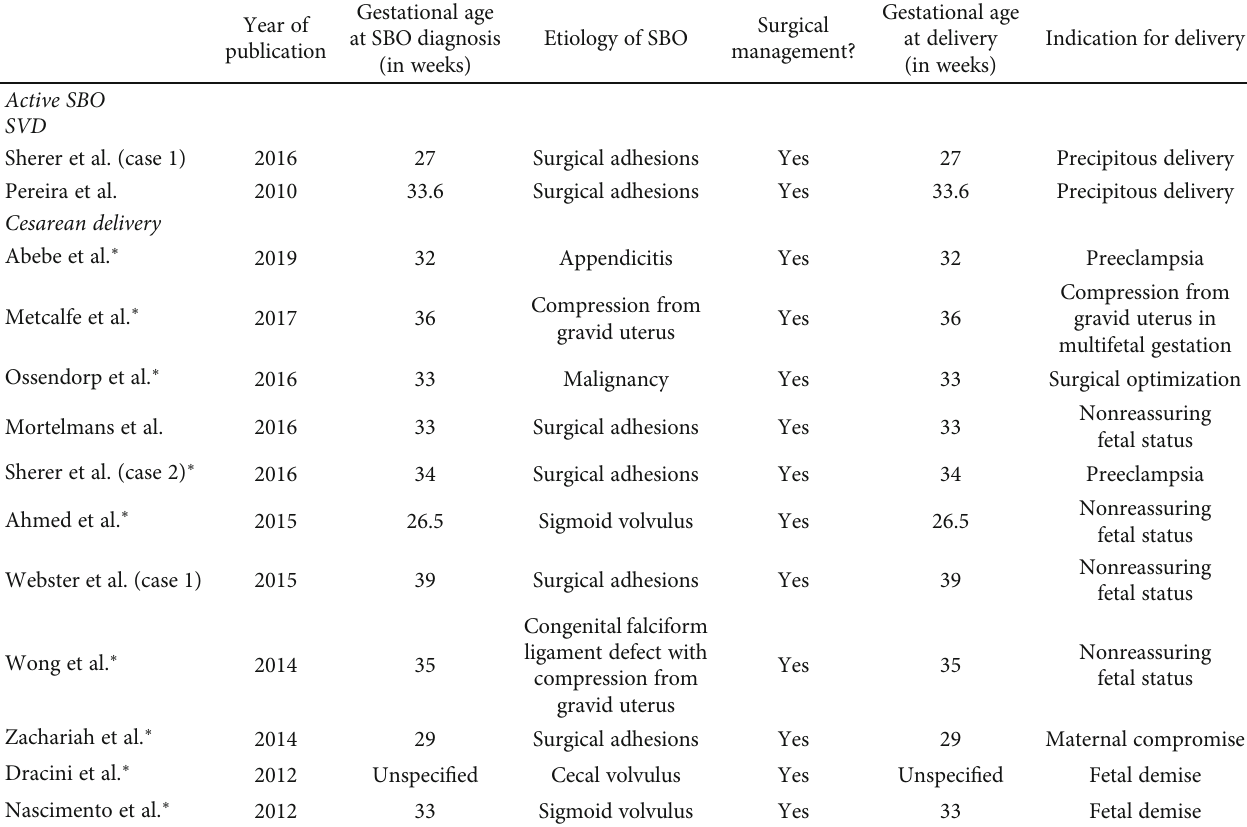
Table 1: Summary of cases with delivery during acute small bowel obstruction from 2010 to 2020.